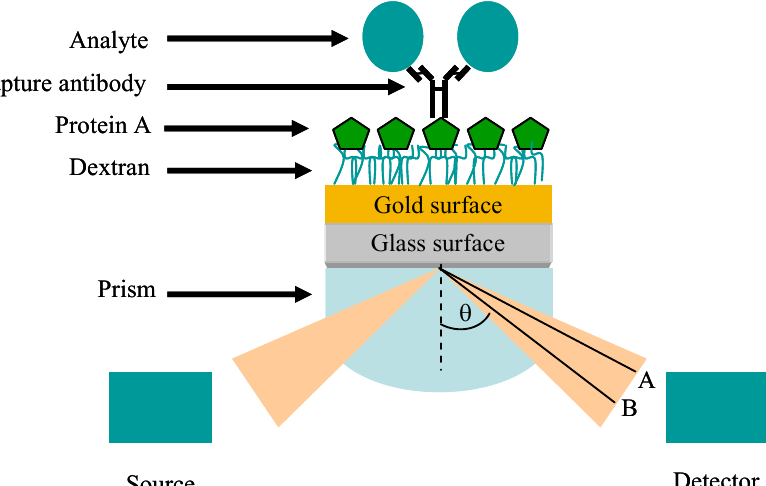
Figure 5. Representation of the SPR phenomenon, showing the Kretschmann prism arrangement originally proposed in references [86] and [87]. For illustrative purposes, a protein-A (green hexagon)-captured IgG antibody is shown on a carboxymethylated dextran (CM5) sensor surface. The mass change introduced by the binding of an analyte of interest (blue circle) is shown as a change in refractive index (A to B) which can be determined through the use of dedicated